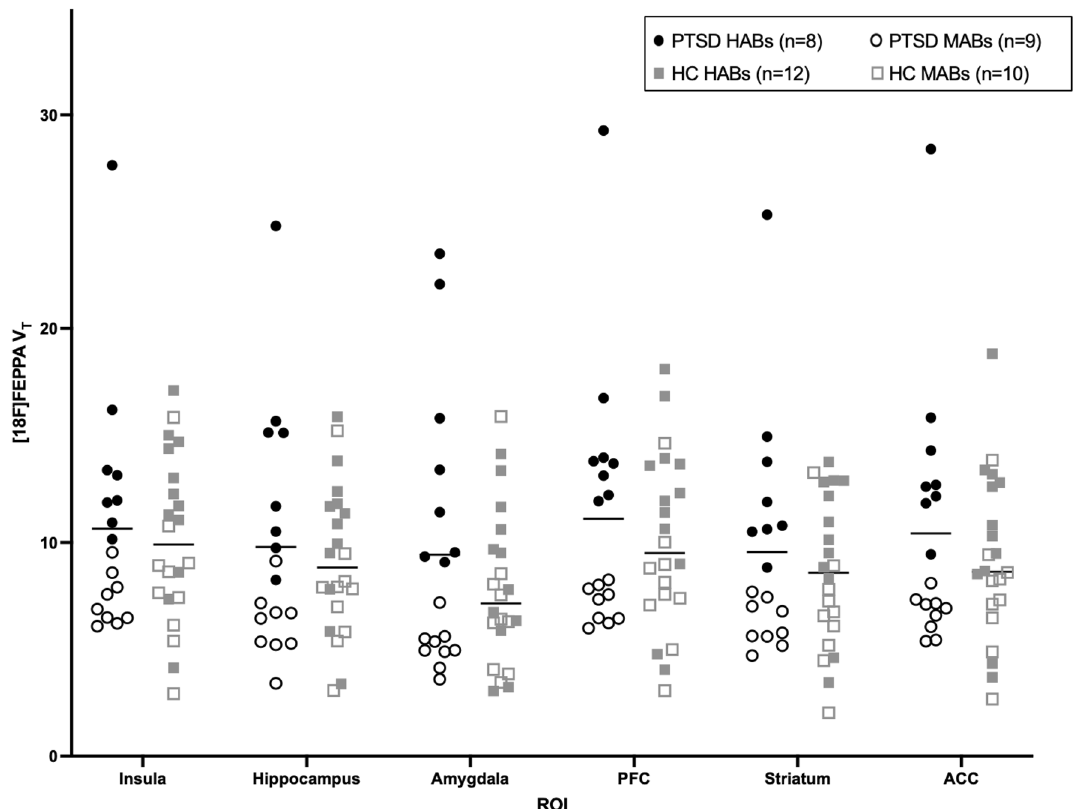
Figure 1. Group differences in [ 18 F]FEPPA V T . [ 18 F]FEPPA V T scatterplot between PTSD (n = 8 HABs [solid]/9 MABs [outline]) and Healthy Controls (HC) (n = 12 HABs [solid]/10 MABs [outline]). RM ANCOVA controlling for genotype and age revealed no main effect of group (F (1,35) = 1.123, p = 0.297) and a marginal ROI × Group interaction (F (2.645,92.571) = 1.954, p = 0.134). Pairwise comparisons: Insula (6.5% difference, p = 0.596); Hippocampus (12% difference, p = 0.279); Amygdala (30% difference, p = 0.107); PFC (16% difference, p = 0.406); Striatum (22% difference, p = 0.328); and ACC (15% difference, p =